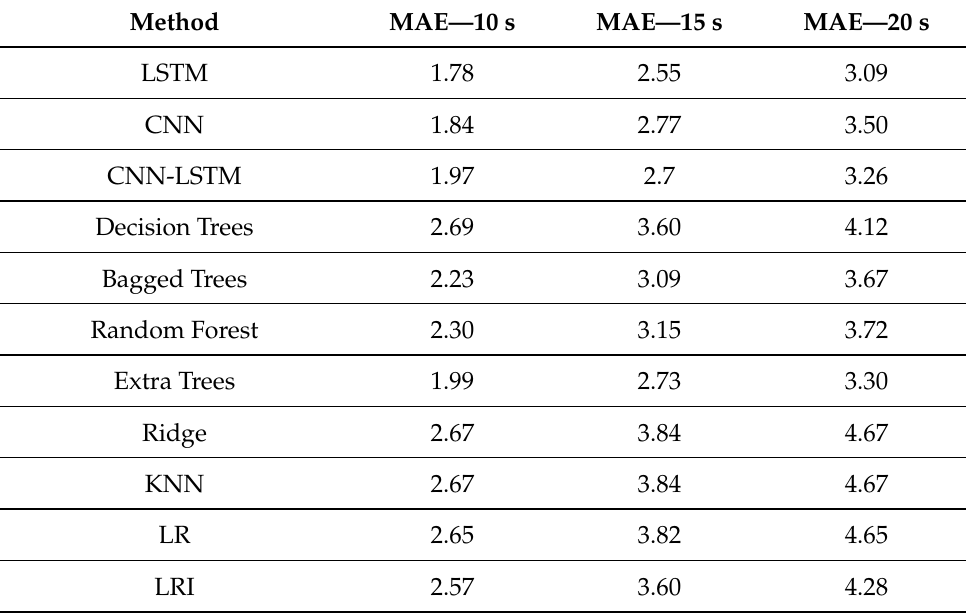
Table 5. The candidate prediction methods results organized from best performing to worst